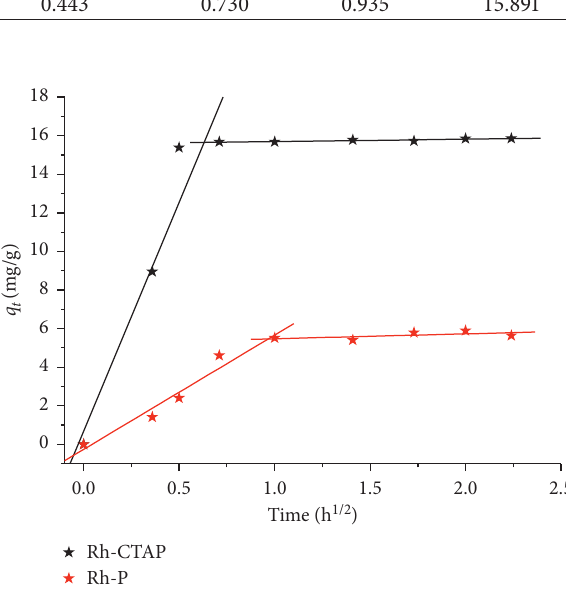
Figure 9: Model of intraparticle diffusion of thymol onto the Rh-P and Rh-CTAB. Table 6: Intraparticle diffusion parameters of thymol onto the Rh-P and Rh-CTAB. 1st line 2nd